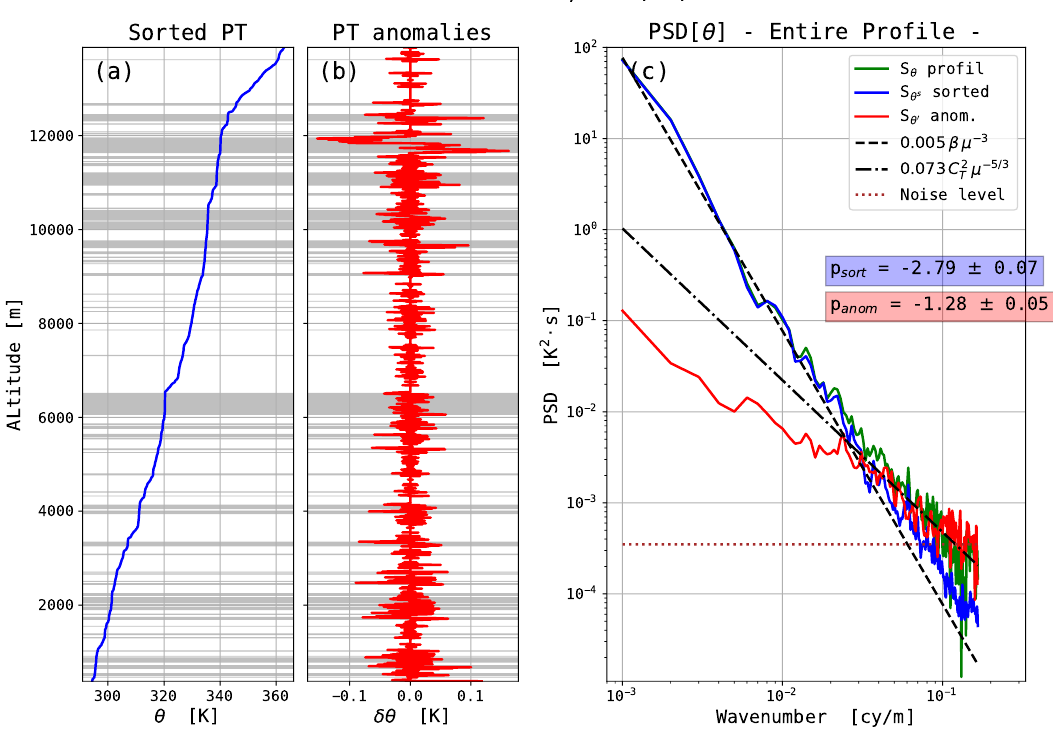
Figure 12. ( a ) the sorted PT profile for flight T11-51. ( b ) The corresponding PT anomaly profile defined as the difference between the observed and sorted profiles. The shaded areas show the position and depths of the detected unstable layers by the Thorpe method. ( c ) Power spectra of the observed PT profile (green), of the sorted profile (blue) and of the anomaly profile (red). The dashed and dash-dotted lines show the theoretical spectra for saturated internal gravity waves (IGW) and for inertial turbulence,